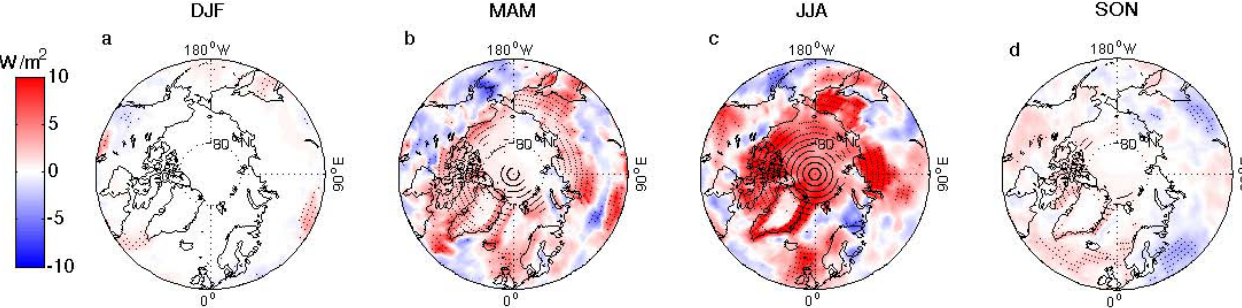
Mode, pattern in winter. The strength of the polar vortex is weaker in the presence of the particulate impurity